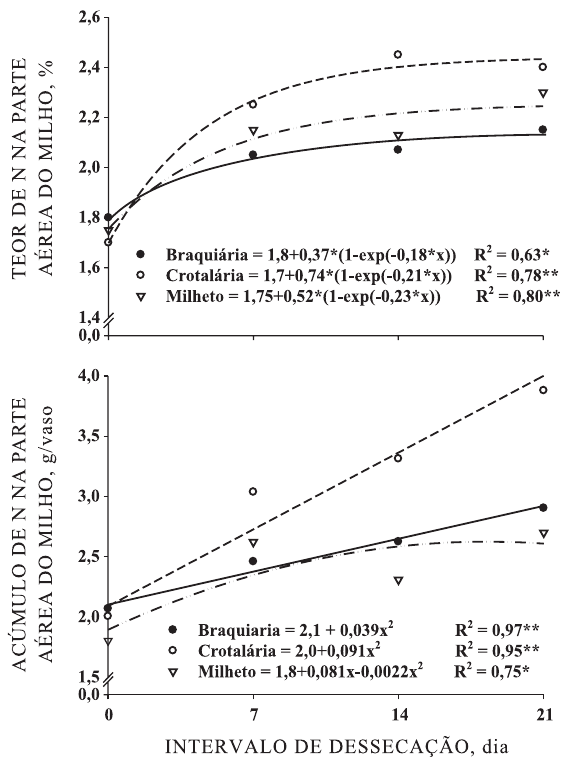
Figura 4. Teor e acúmulo de nitrogênio na planta de milho, em função do intervalo de dessecação, em diferentes espécies de plantas de